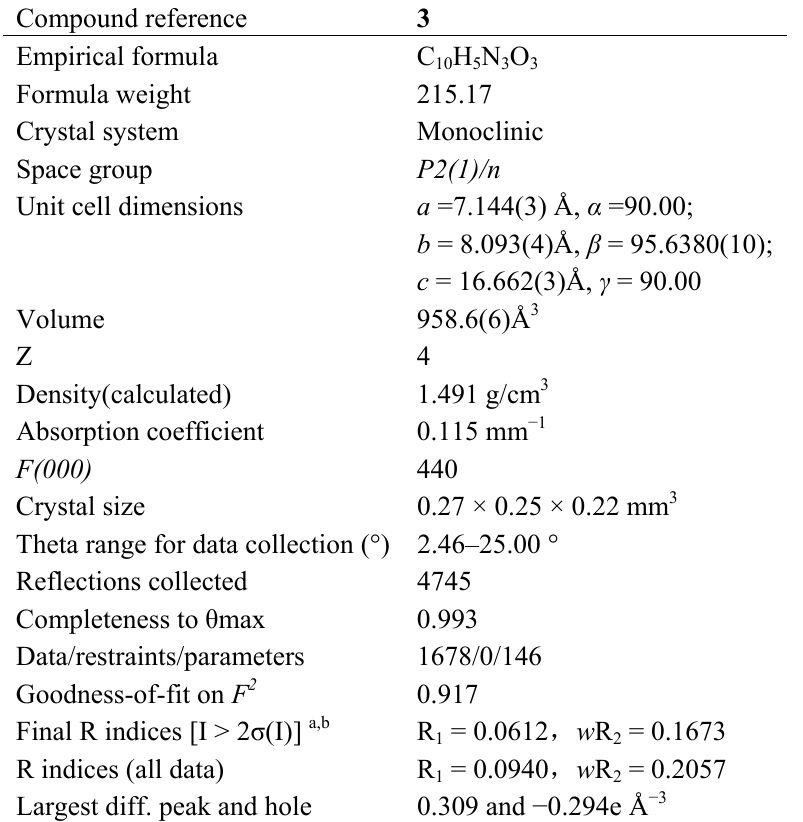
Table 4. Crystal data and re fi nement details for 3